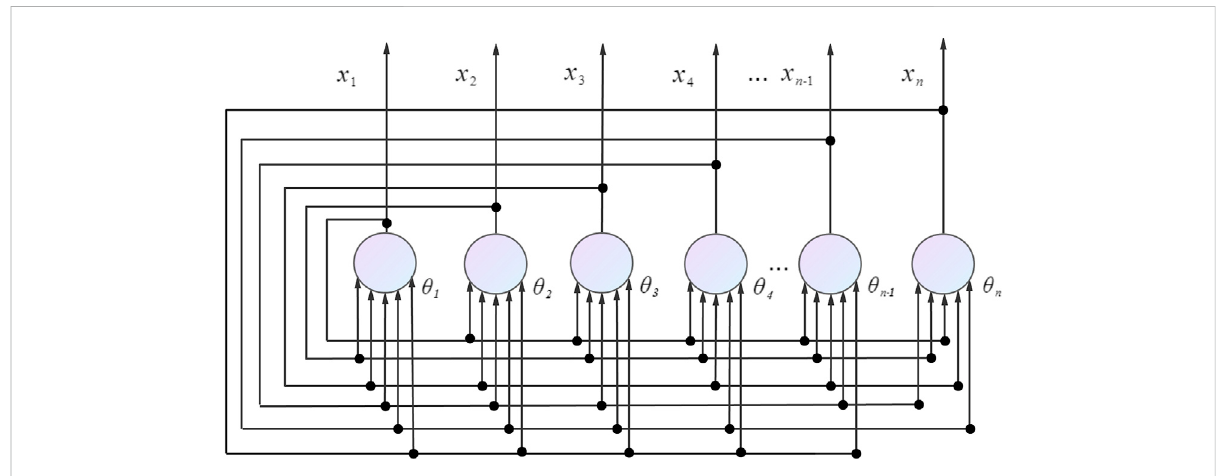
FIGURE 2 HNN topology operating structure and mode of